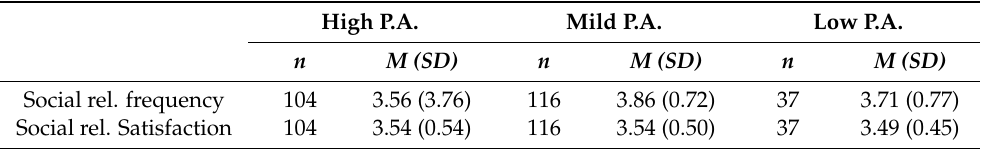
Table 2. Means and standard deviations of the scores on the social relations subscales (CUBRECAVI) according to the level of activity. High P.A. Mild P.A. Low P.A. n M (SD) n M (SD) n M (SD) Social rel. frequency 104 Social rel. Satisfaction